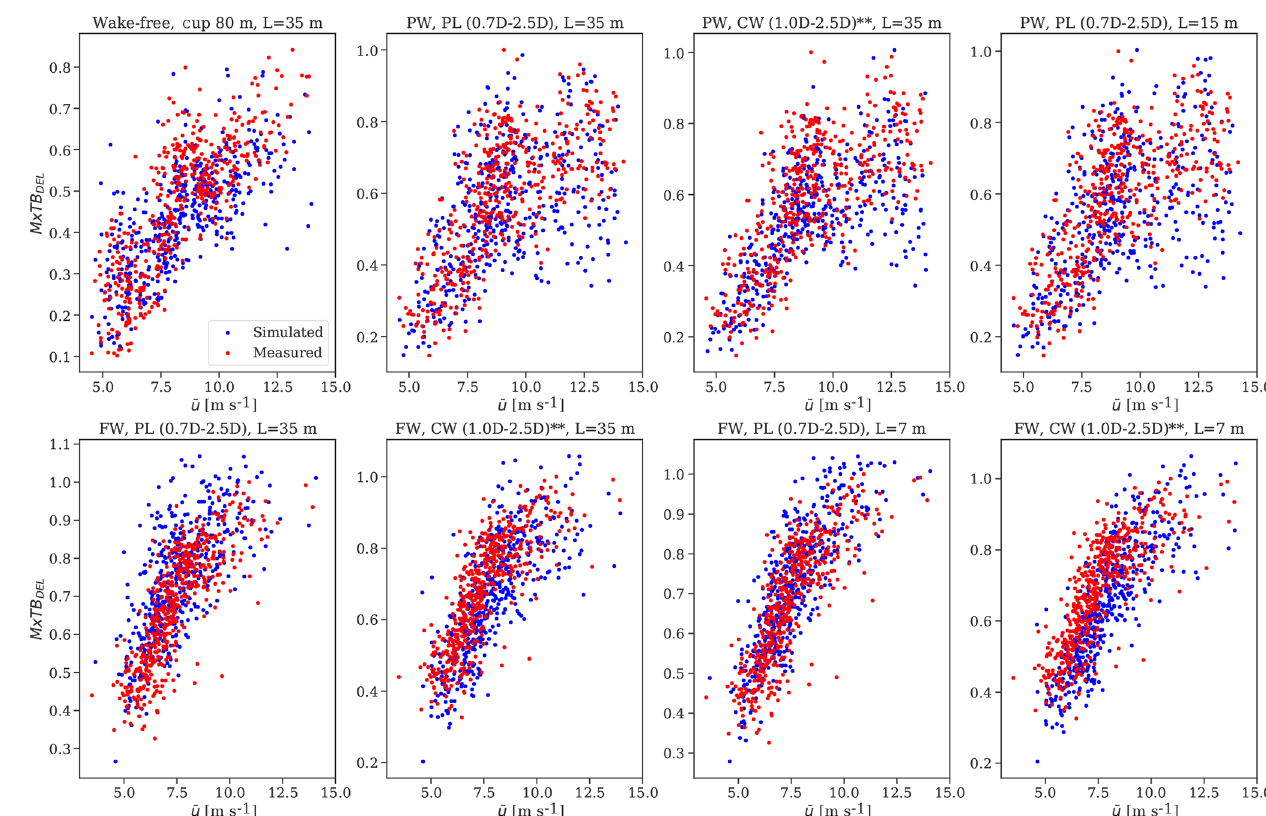
Figure C4. Scatter plots of the normalized measured and predicted fatigue fore–aft tower bottom bending moment realizations used in the